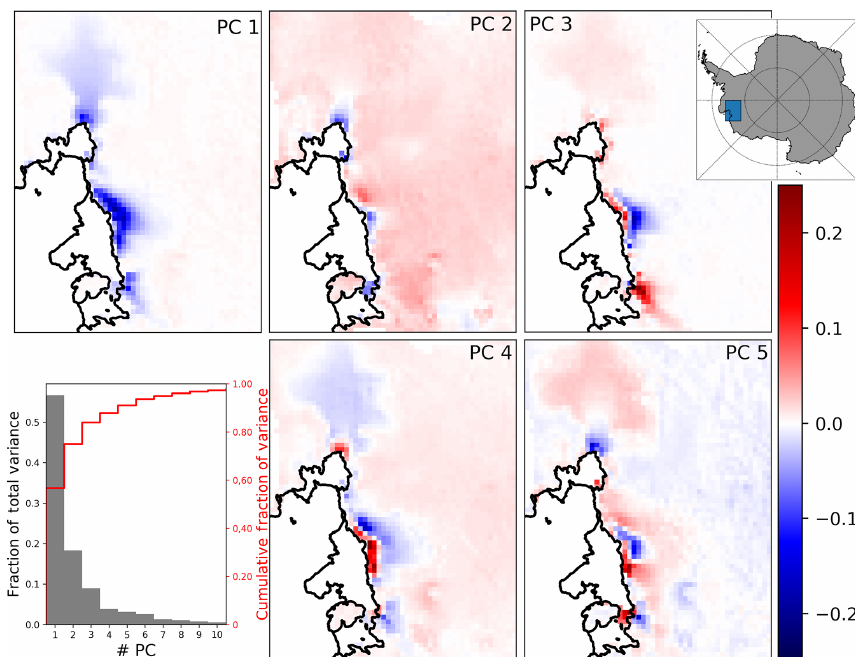
Figure 2. The first five normalised PCs of the model ice thickness change fields, building an orthogonal basis. They represent the main modes of variation in the model ensemble and are unitless since normalised. The lower left graph shows the fraction of total variance represented by each PC individually (grey) and cumulatively (red), based on squared singular values.